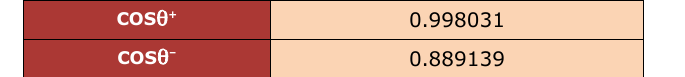
Table 5.Degree of conflict between the alternative (France as a sample) and PIS and